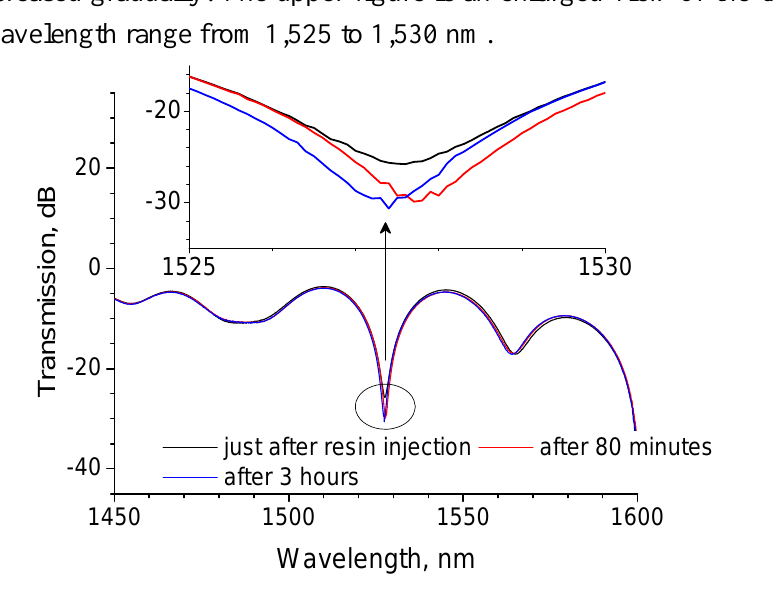
Figure 16. Transmission spectra of an LPG after resin